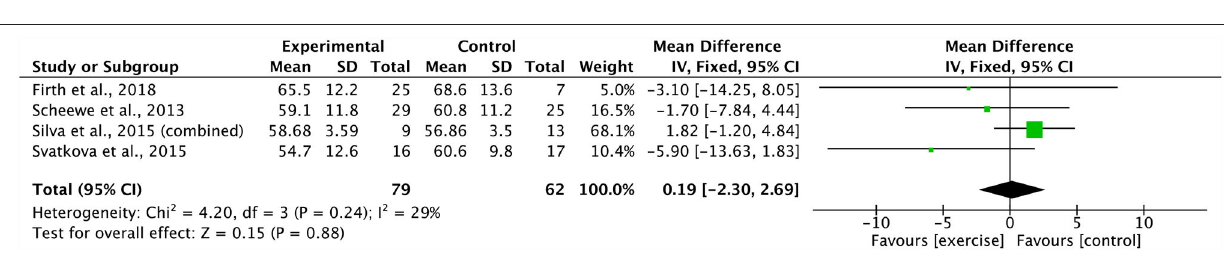
FIGURE 8 | The effects of combined aerobic and resistance training on PANSS total